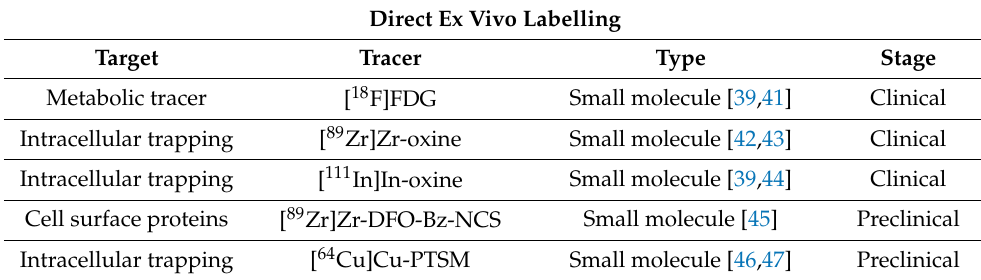
Table 1. Tracers and targets of the direct ex vivo labelling method used in adoptive cell transfer. Direct Ex Vivo Labelling Target Tracer Type Stage Metabolic